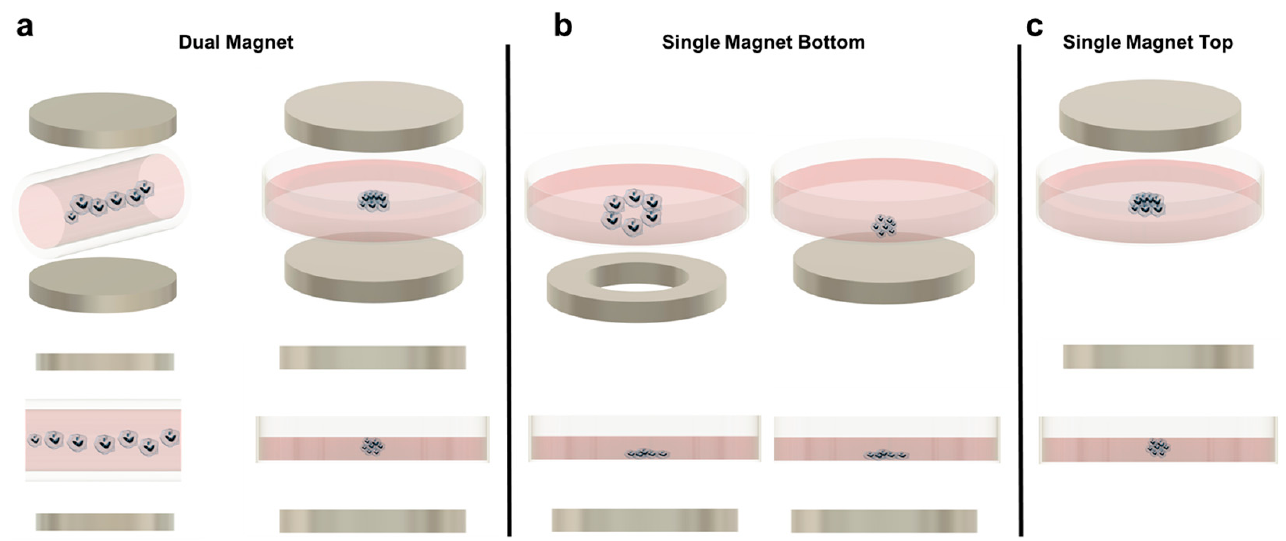
Figure 1. ( a ) Magnetic levitation with dual magnet configuration for cell patterning. Left: Dual magnet using a capillary tube to create a row of spheroids. Right: Dual magnet using a Petri dish to levitate cells. ( b ) Single magnet bottom patterning. Left: Ring magnet in the bottom for cell patterning leaving a void in the middle. Right: Single magnet bottom arranging the cells flat in the bottom of the Petri dish. ( c ) Single magnet top patterning.